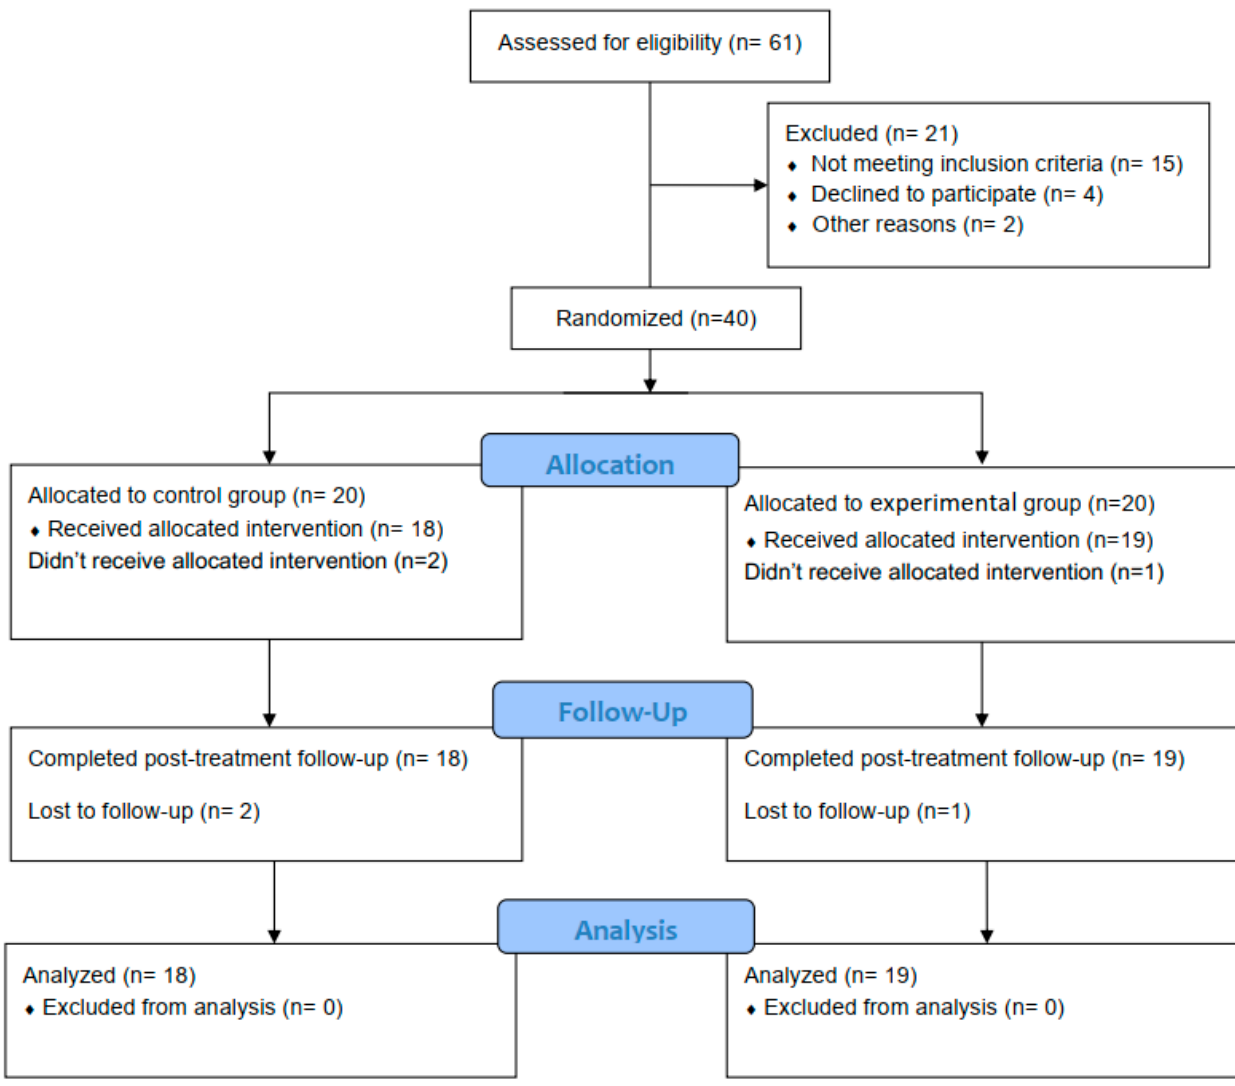
Figure 1. Participants’ CONSORT flowchart. Table 2. Demographic and clinical characteristics of children in the IMT and control groups.